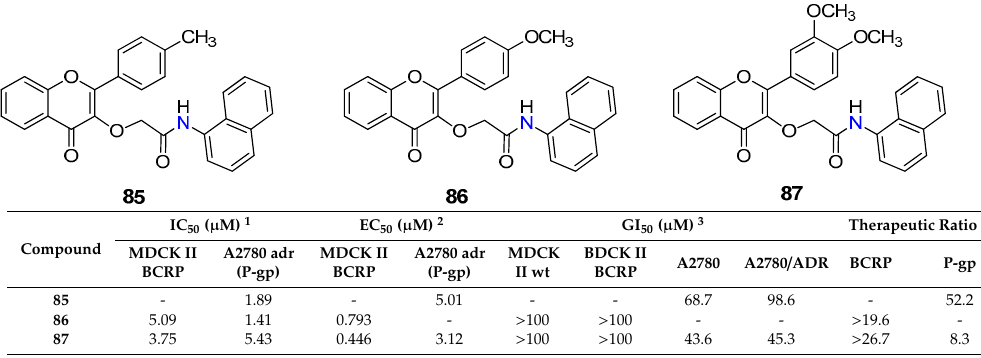
Table 8. MDR reversal effects of flavone derivatives 85 – 87 against BCRP and P-gp [103].